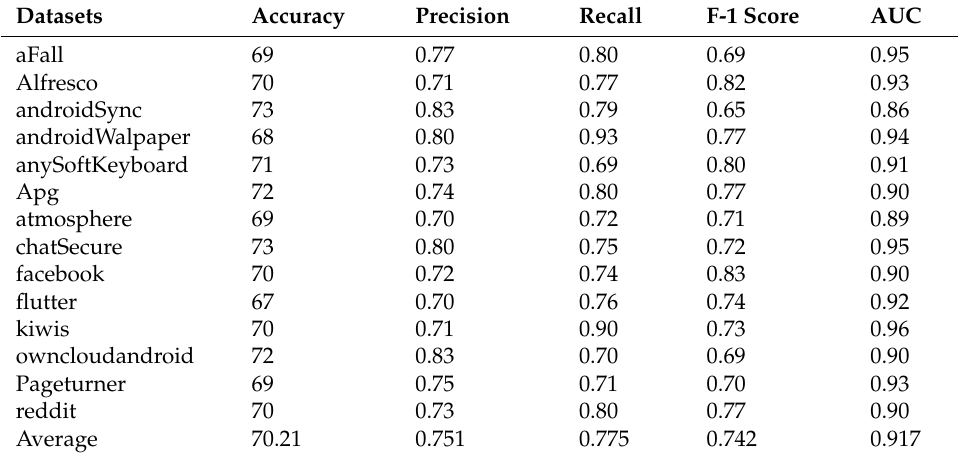
Table 4. LSTM defect prediction results (within-project analysis).